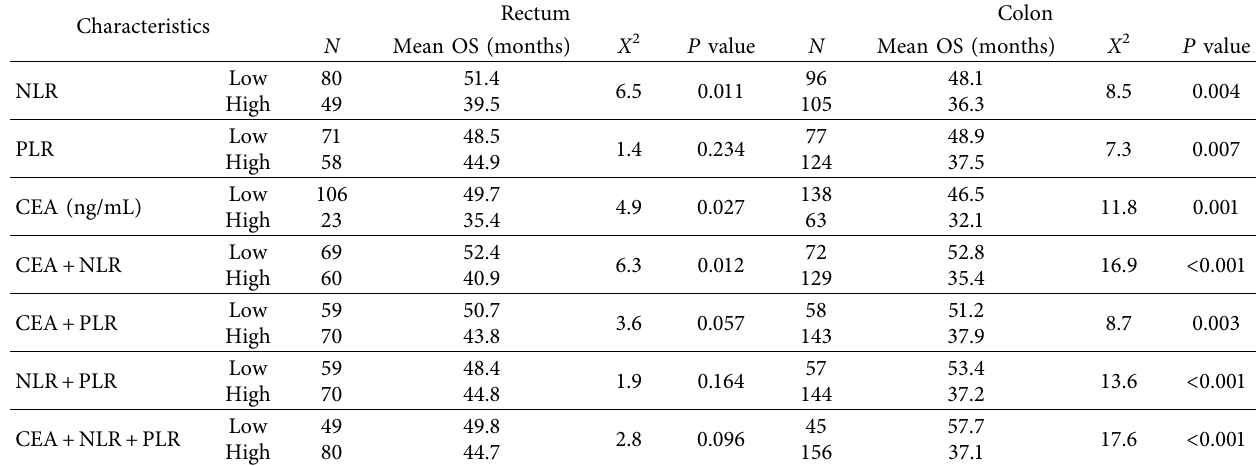
Table 3: Kaplan–Meier survival analysis and log-rank test compared in the primary